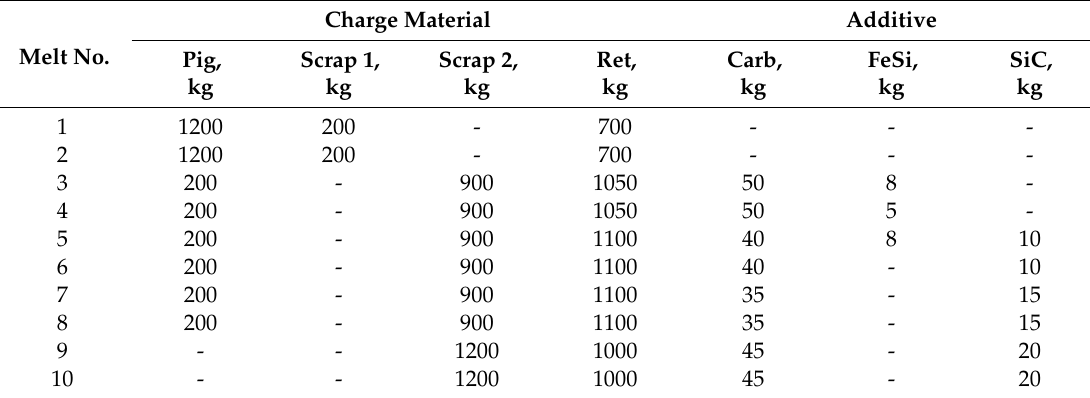
Table 1. List of charge materials and